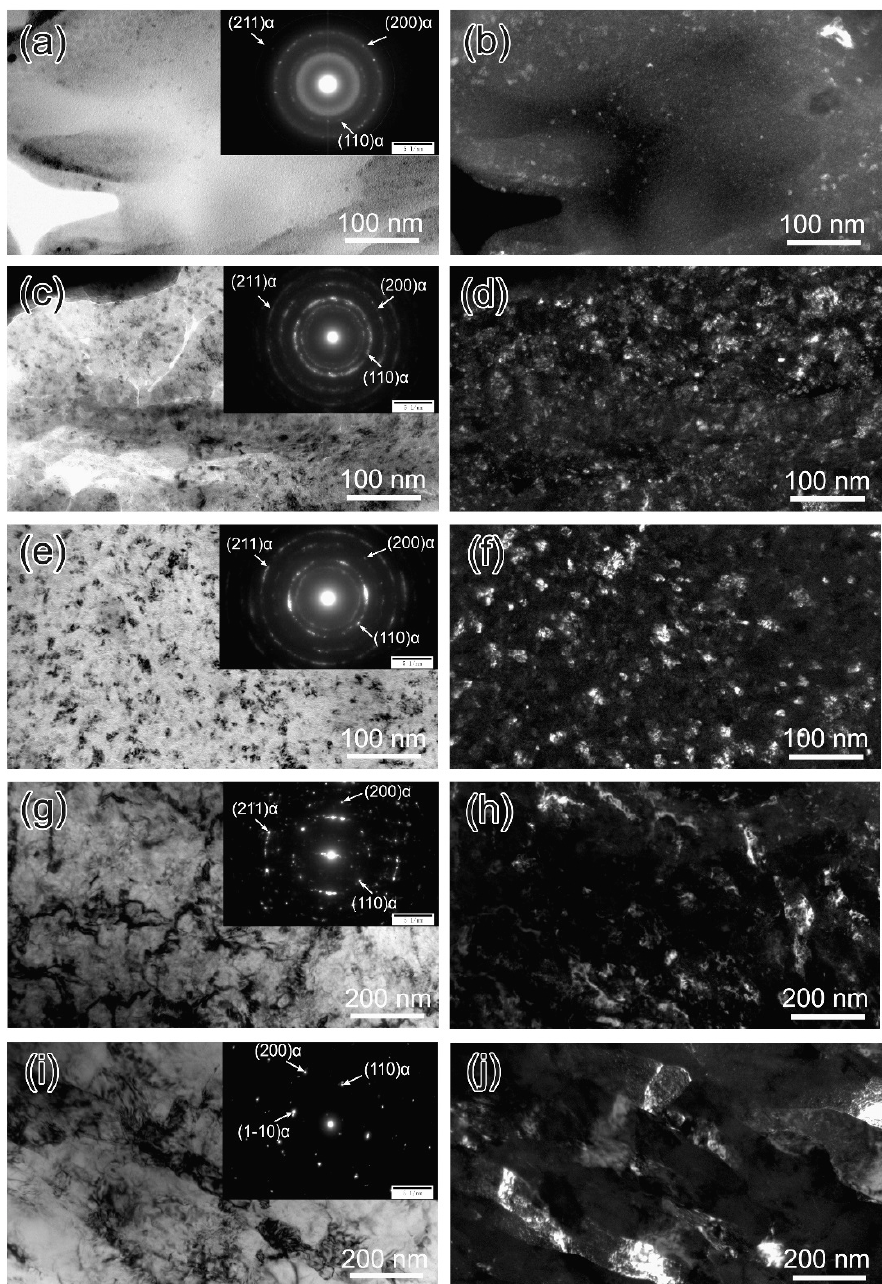
Figure 7. Bright ( a , c , e , g , i ) and dark ( b , d , f , h , j ) field TEM images taken from different depth of the deformed layer from the outmost surface into deeper for B45 after wear testing under 75 N, in the corner of bright field images were selected area diffraction patterns (SADPs), the surface amorphization and nanocrystallization were confirmed.